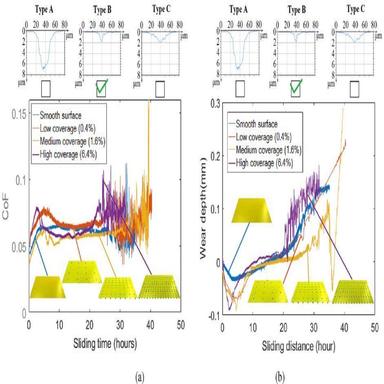
Measurement of (a) friction coefficient and (b) wear progression for different coverages of Type B (narrow & shallow) dimples.